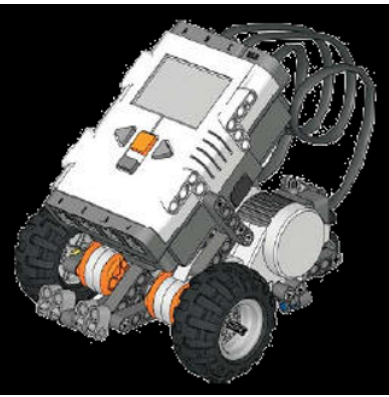
Figure 4. LEGO Mindstorm NXT Robot – Tribot Configuration Photo Courtesy thenxtstep.blogspot.com